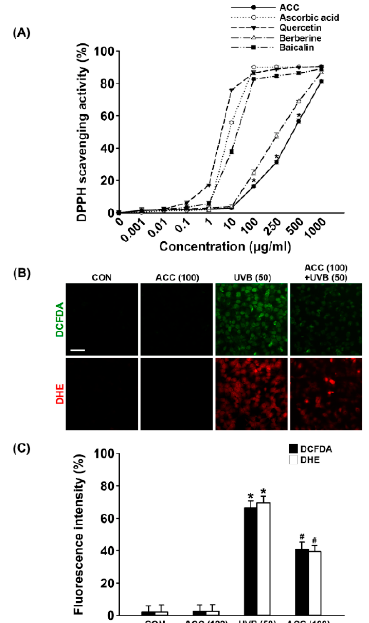
Figure 4. Antioxidative effect of ACC in UVB-irradiated HaCaT cells. ( A ) Effect of ACC and single natural compounds on 2,2-diphenyl-1-picrylhydrazyl (DPPH) radical scavenging activity. Four active compounds, ascorbic acid, quercetin, berberine, and baicalin, were used as positive controls. * p < 0.001 vs. no treatment. ( B ) Images of 2 ′ ,7 ′ -dichlorodihydrofluorescein diacetate (DCFDA) and dihydroethidium (DHE) on ACC treatment in UVB-irradiated cells. DCFDA and DHE stained for H 2 O 2 ( green ) and O 2– ( red ) in HaCaT cells following UVB irradiation at 50 mJ/cm 2 . ( C ) The fluorescence intensity of DCFDA and DHE on ACC treatment in UVB-irradiated cells. CON, control cells. Scale bar, 50 µm. * p < 0.001 vs. CON; # p < 0.001 vs. UVB (50). All experiments were repeated at least three times, and similar results were obtained.